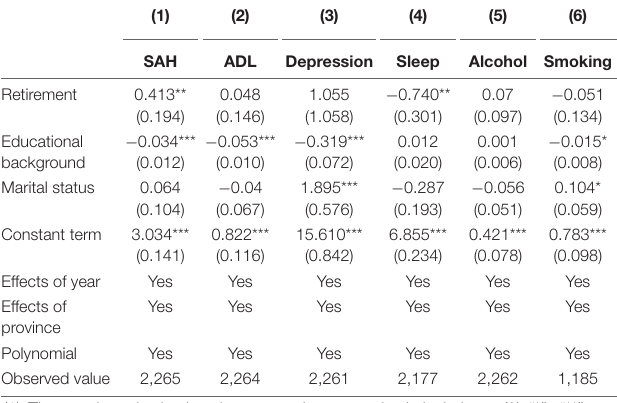
TABLE 5 | Effects of educational background and marital